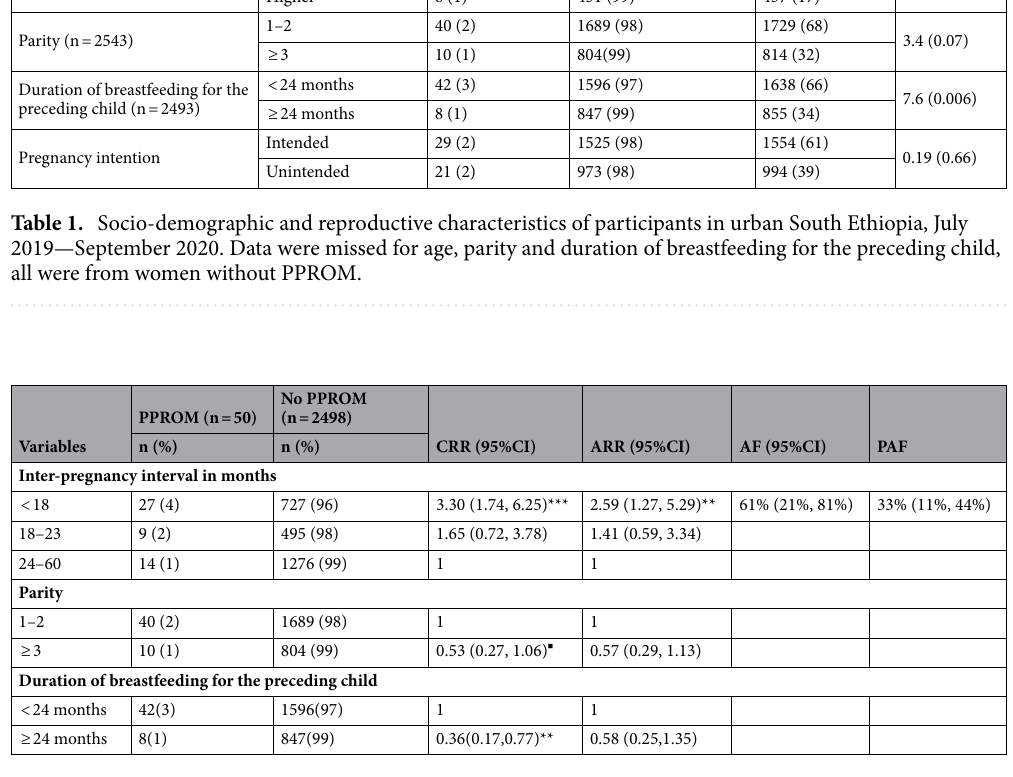
Table 2. Multivariable generalized linear model for the association of PPROM with IPI in urban South Ethiopia, July 2019–September 2020. CRR crude relative risk, ARR adjusted relative risk, AF attributable fraction, PAF population attributable fraction, CI confidence interval, 1 reference category. RR adjusted for parity and duration of breastfeeding for the preceding child. ***P < 0.001, *P < 0.05, ▪ P < 0.25.